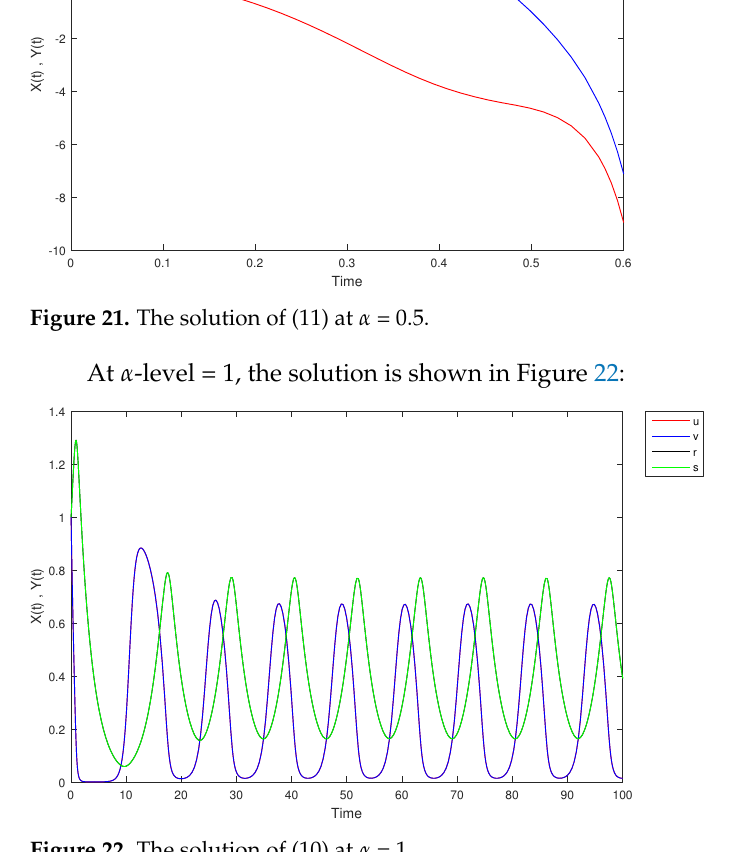
Figure 22. The solution of (10) at α =